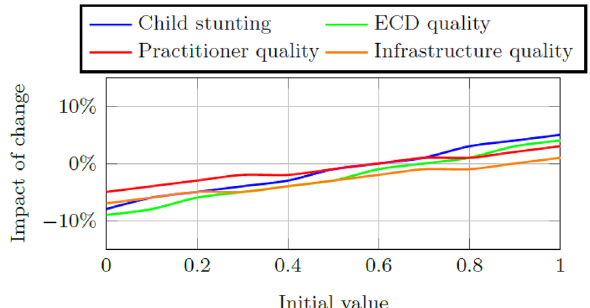
Fig. 8 Impact on the final child aptitude score per change in the initial value of child stunting, ECD quality, practitioner quality, and infrastructure quality, respectively, in Quintiles 1–3